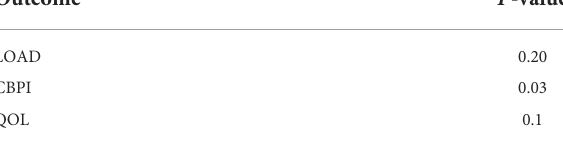
TABLE 6 Significance of PRP on the outcome (univariate analysis). Outcome P -value LOAD 0.20 CBPI 0.03 QOL